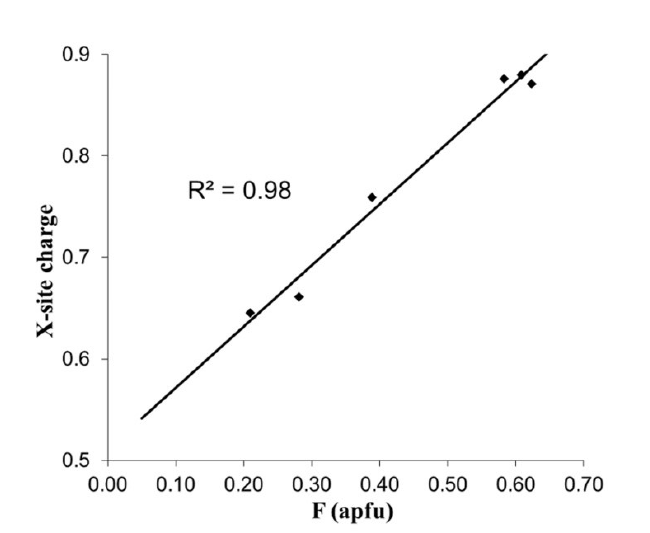
Figure 3. Correlation between the average X-site charge (only Na 1 + , Ca 2 + , K 1 + ) in Cu-bearing tourmalines from the Mulungu mine, Rio Grande do Norte, Brazil (samples from [26]).